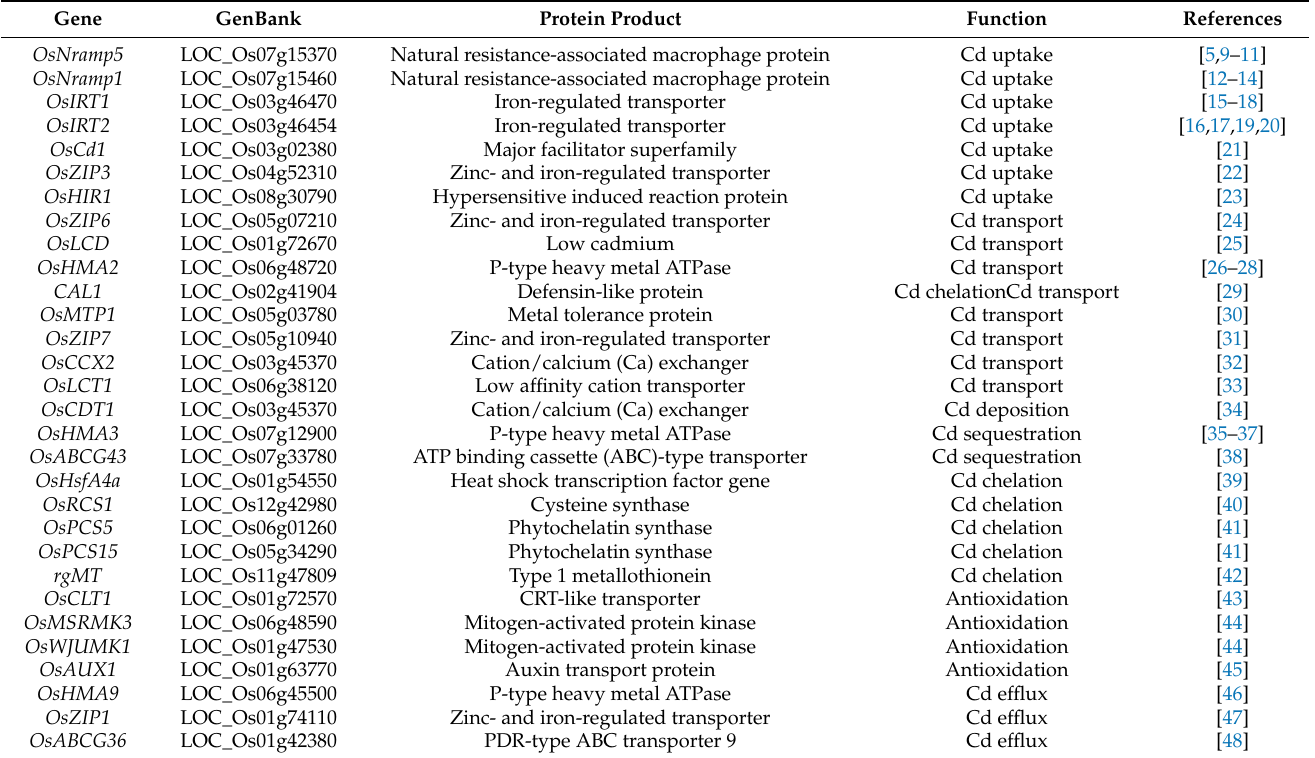
expressing rice OsNramp1 suffers more serious toxicity under Cd stress [13]. Table 1. Cd uptake, transport and resistance-related genes in rice.